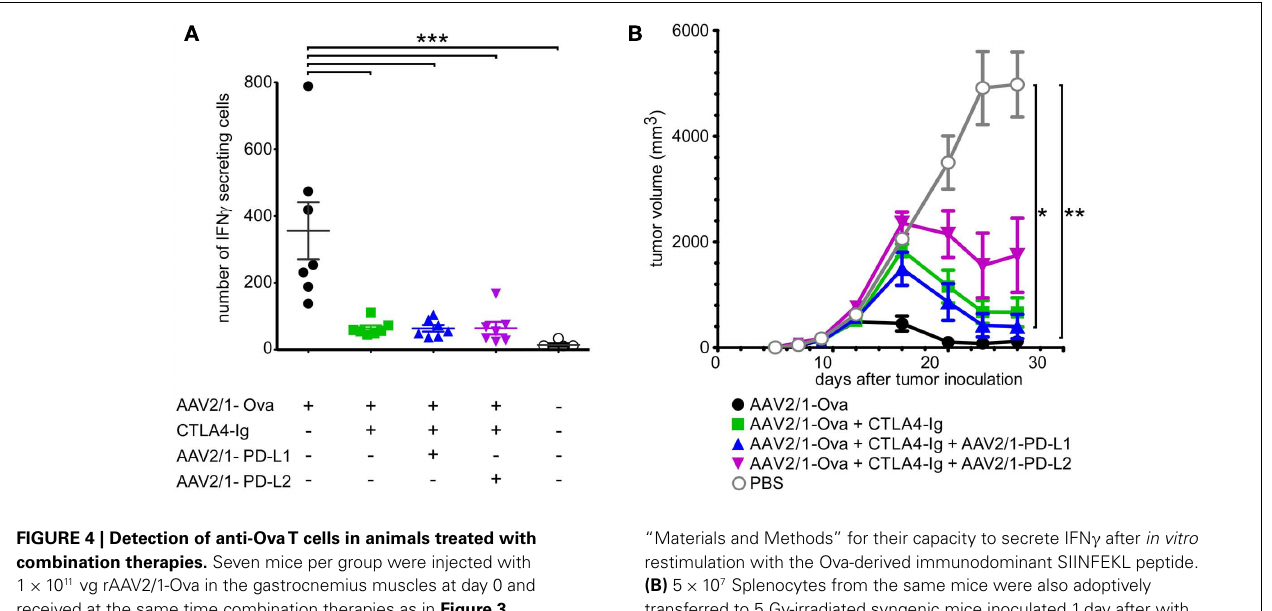
FIGURE 4 | Detection of anti-OvaT cells in animals treated with combination therapies. Seven mice per group were injected with 1 × 10 11 vg rAAV2/1-Ova in the gastrocnemius muscles at day 0 and received at the same time combination therapies as in Figure 3 . Splenocytes were then harvested 80days after and analyzed for the presence of lymphocytes capable to respond to Ova antigen. (A) Splenocytes were analyzed by ELISpot as described in the Section